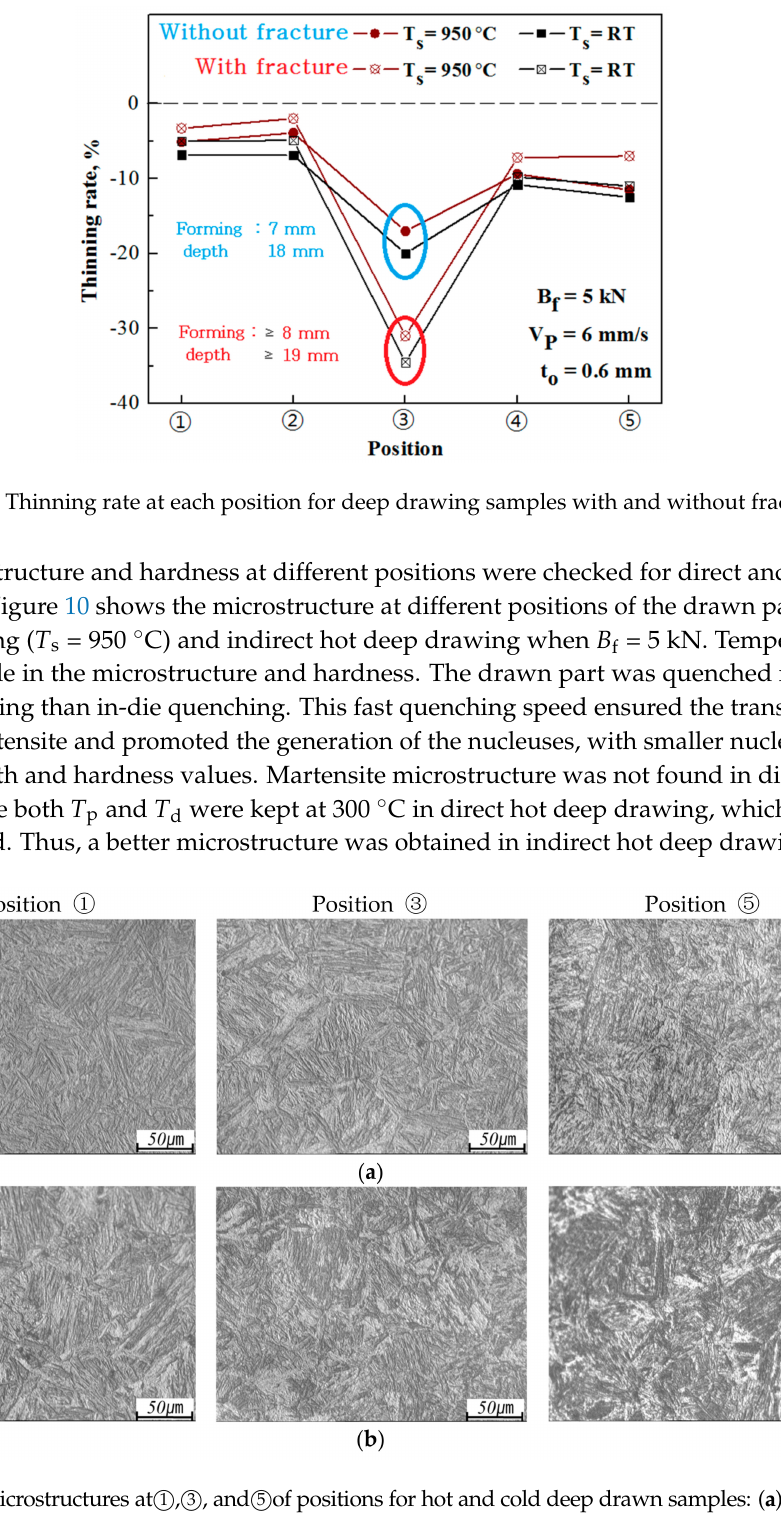
Figure 10. Microstructures at 1 (cid:13) , 3 (cid:13) , and 5 (cid:13) of positions for hot and cold deep drawn samples: ( a ) hot deep drawing ( T s = 950 ◦ C); ( b ) cold deep drawing and water quenching after heating temperature to 900 ◦